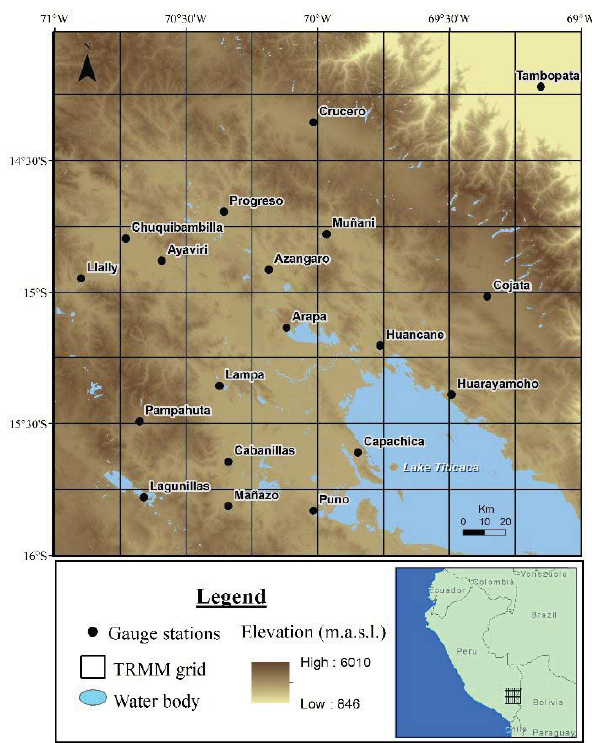
Figure 2. Study region: stations (black dots) and TRMM 8 × 8 cell grid (black